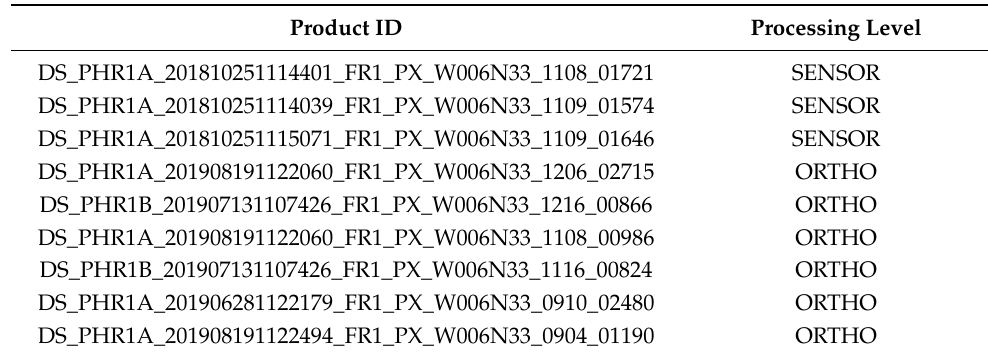
Figure 3. Sentinel 2 imagery acquired on 23 July 2016 of the Plateau of Azrou: in yellow the 357 identified sinkholes through photointerpretation. Table 2. List of the Pleiades data acquired in this